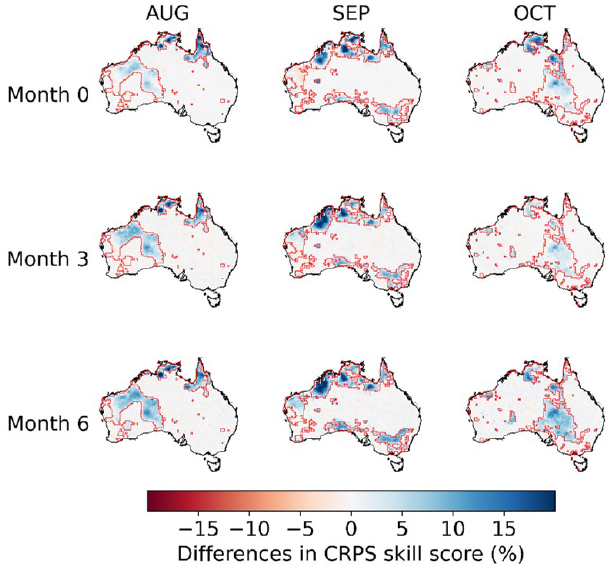
Figure 2. Differences in the correlation coefficient ( r ) between BJP- ti calibrated forecasts and observations with that between BJP cal- ibrated forecasts and observations for 3 selected months (August, September, and October) and three lead times (months 0, 3, and 6). Red polygons show regions with significant observed trends.